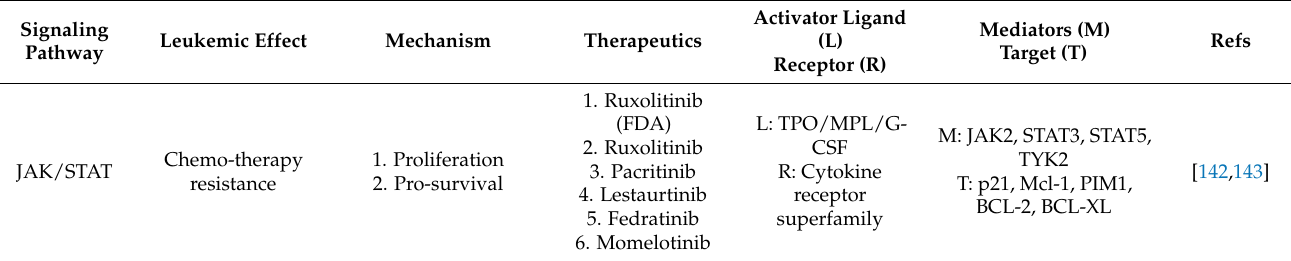
Table 6. Signaling pathways related to AML drug